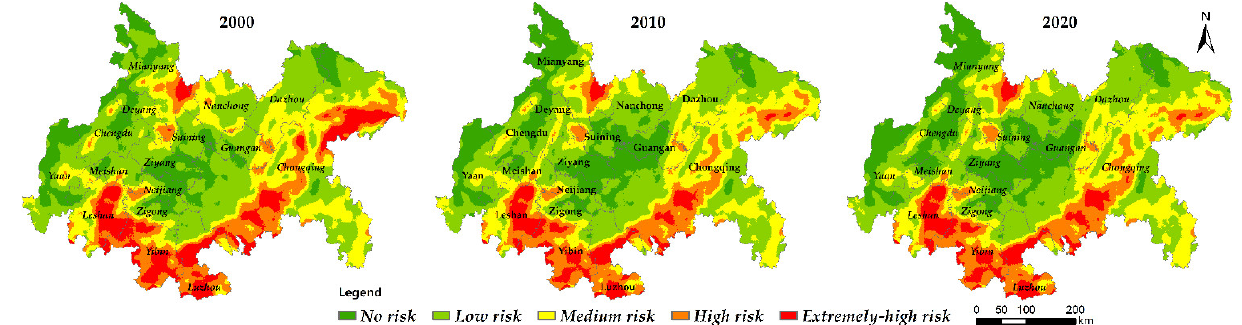
Figure 9. Landscape ecological risk classification from 2000 to 2020.